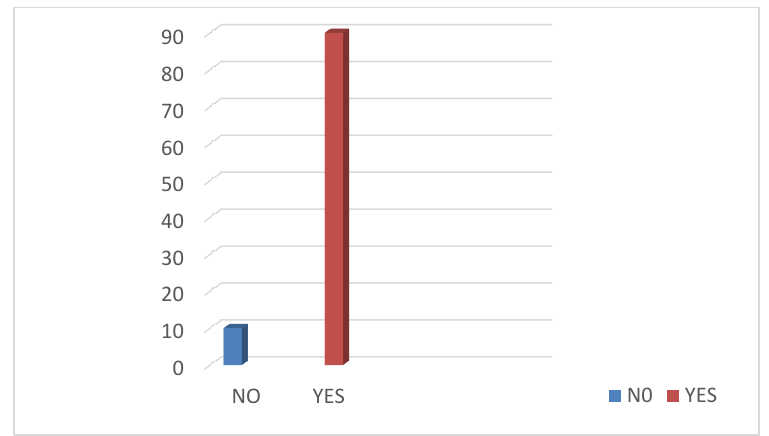
Fig. 1. There is a need for continuous retraining of nurses on psychosocial care